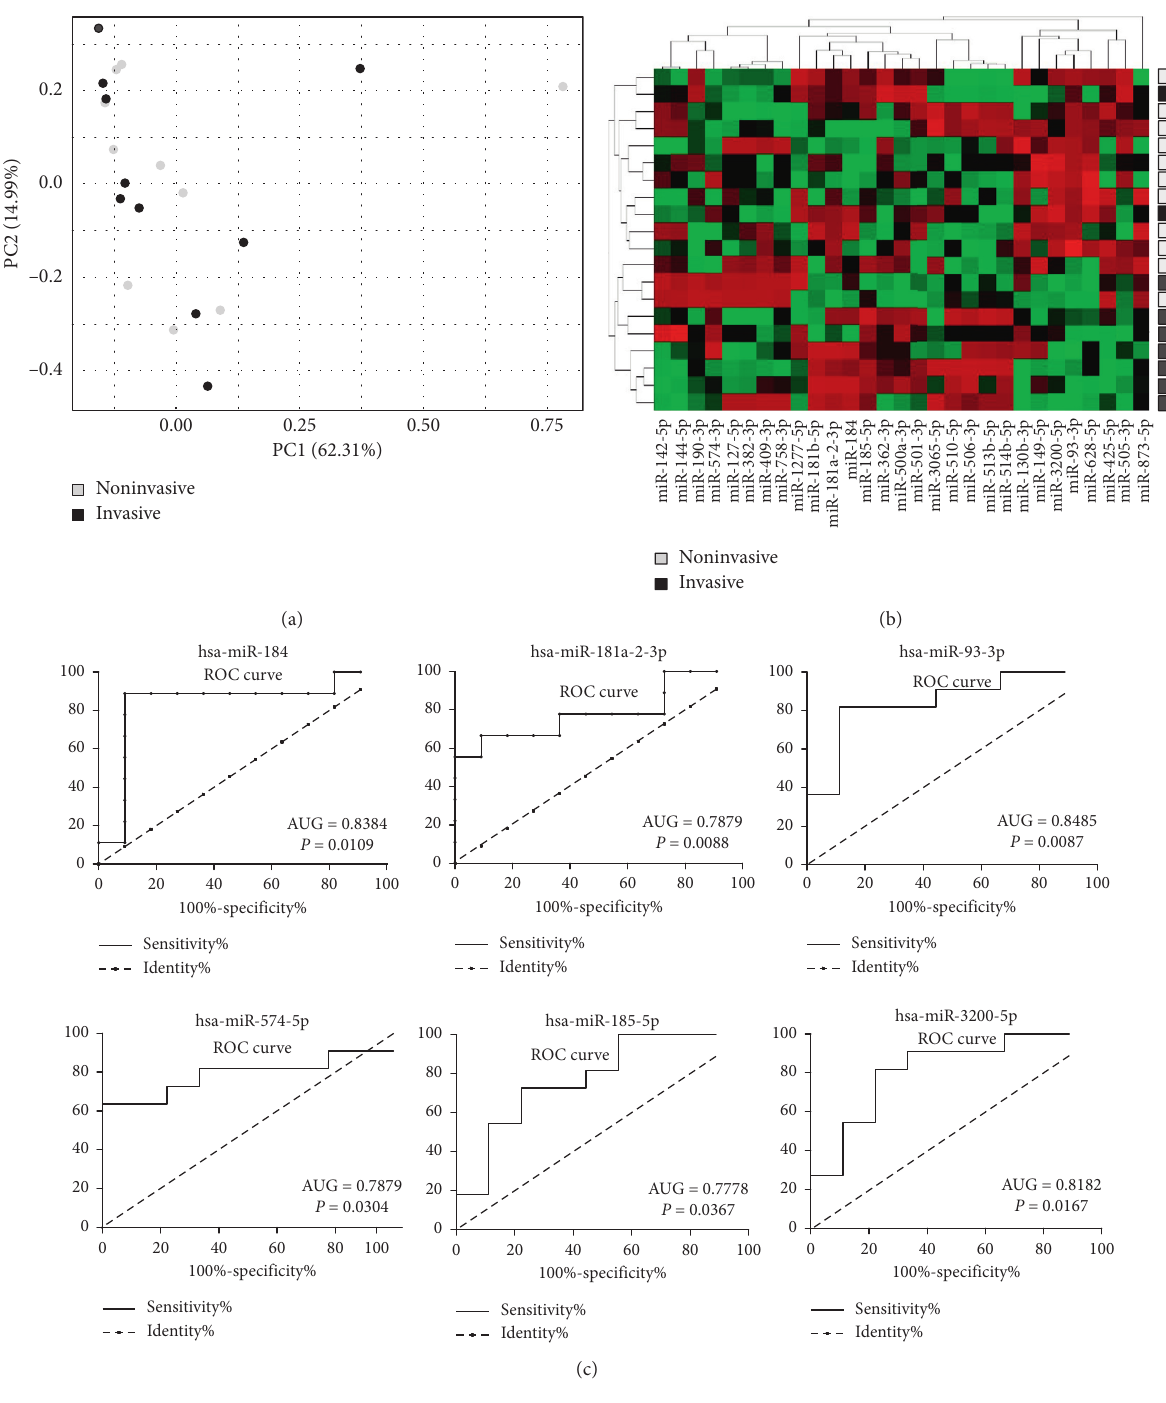
Figure 1: Comparison of miRNA expression in invasive and noninvasive gonadotropic PitNETs with next-generation sequencing. (a) Principal component analysis; (b) heatmap and hierarchical clustering using normalized read counts value for differentially expressed miRNAs; (c) ROC curve analysis for six miRNAs considered as potential markers of invasive